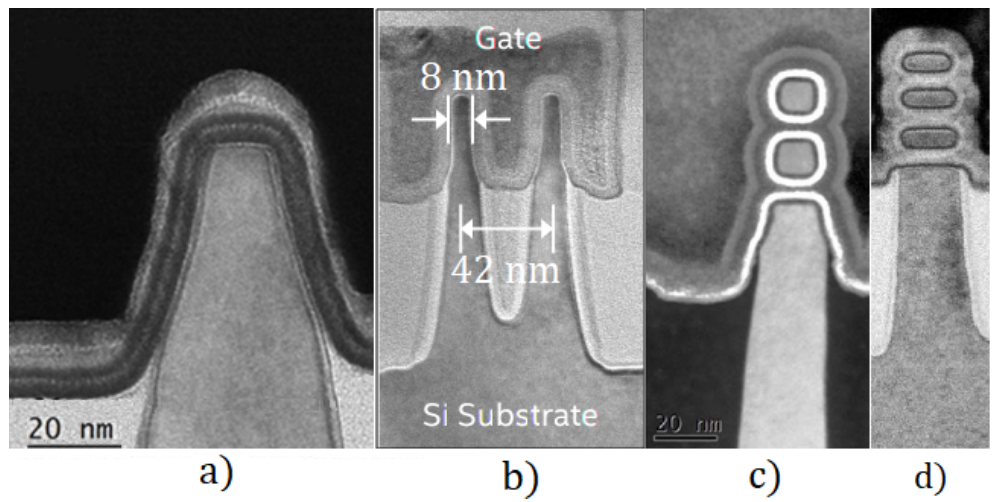
Figure 3. Cross-sectional TEM pictures of novel 3D structures: ( a ) ordinary bulk sub-100 FinFET structure [13] ( b ) 14-nm FinFET by Intel [15] ( c ) 15-nm Ge NWFET [22] ( d ) 5-nm NWFET by IBM [23].